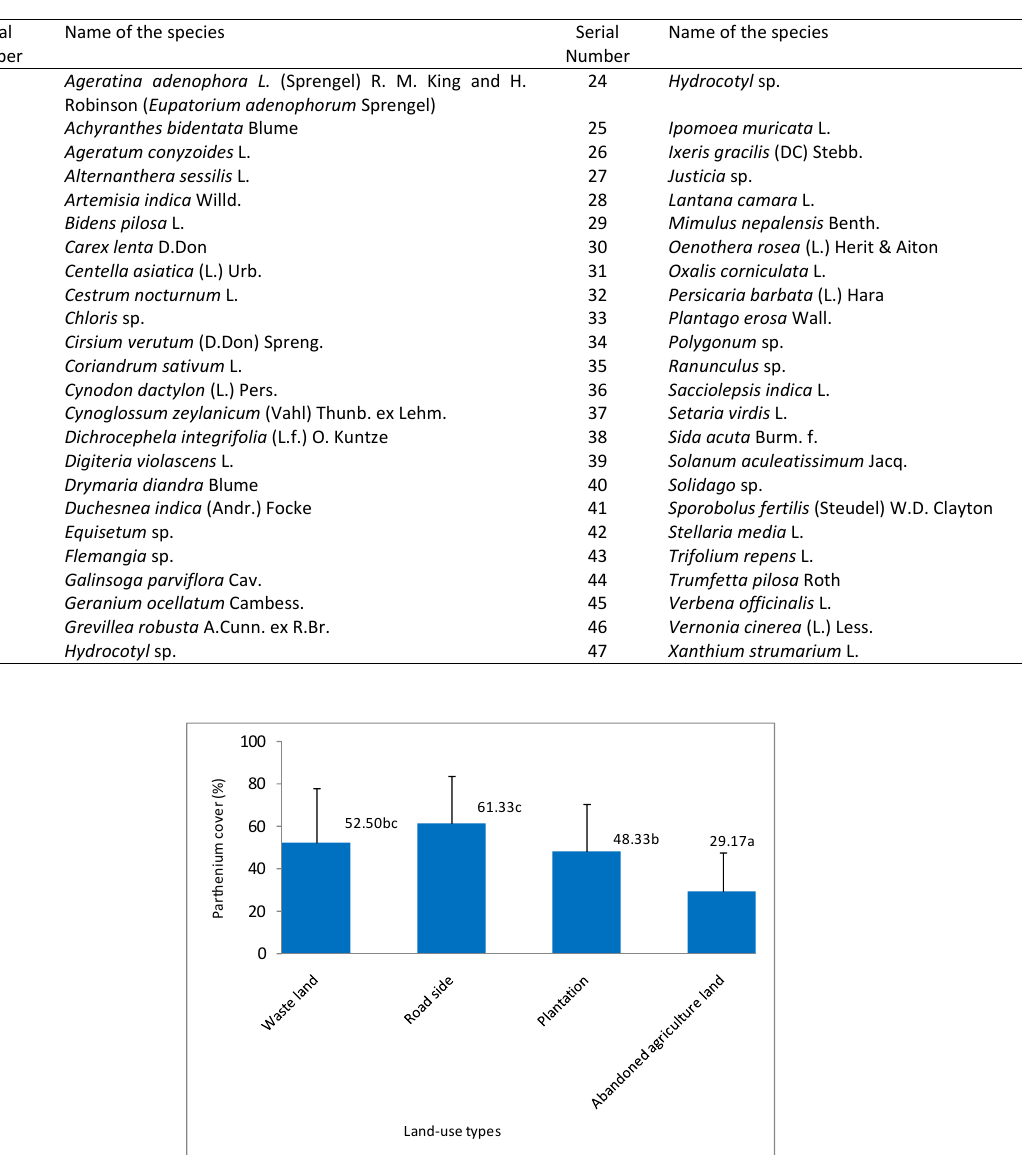
Table 1: List of the plant species recorded in the sampling plots